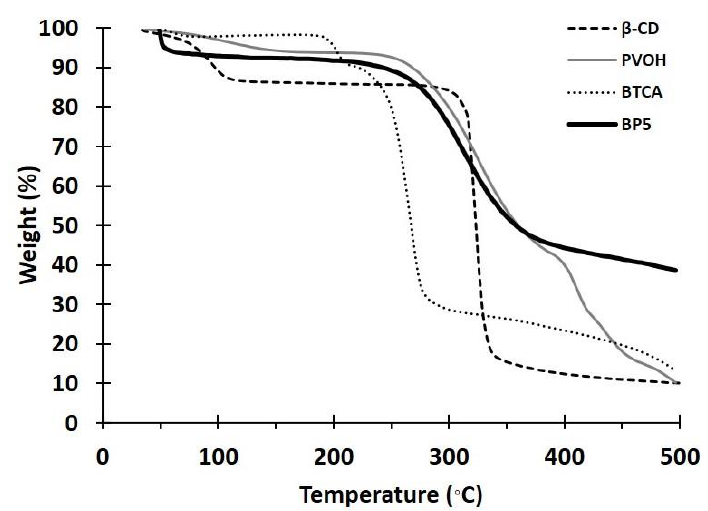
Figure 2. TGA thermograms of BTCA, PVOH, BP5, and β -CD.